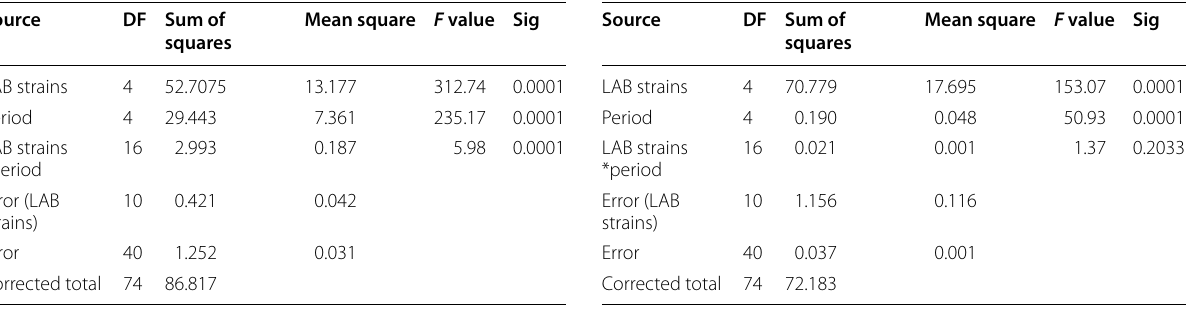
2 °C. Data are represented as weekly bacterial cell counts ± STD). Uppercase letters are results of Tukey test. a − d Means with the same letter ± 0.05) ≤